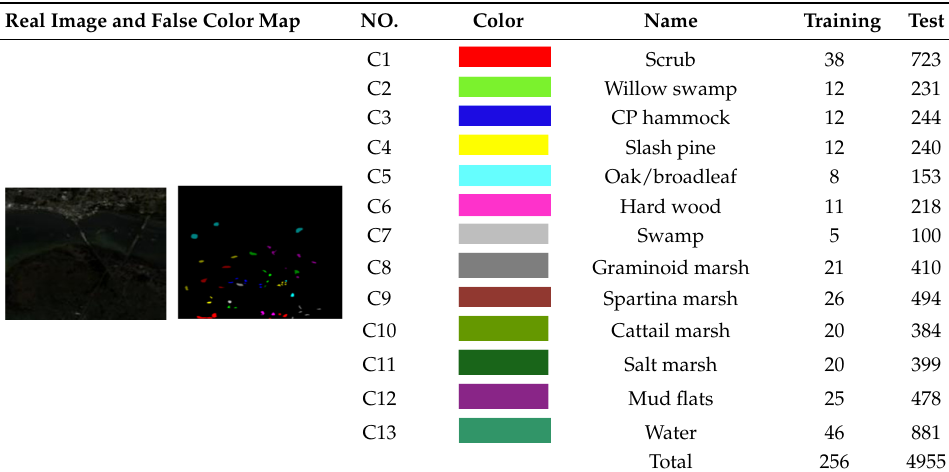
Table 3. Real image, false color map, and number of samples available in the Kennedy Space Center (KSC) dataset.